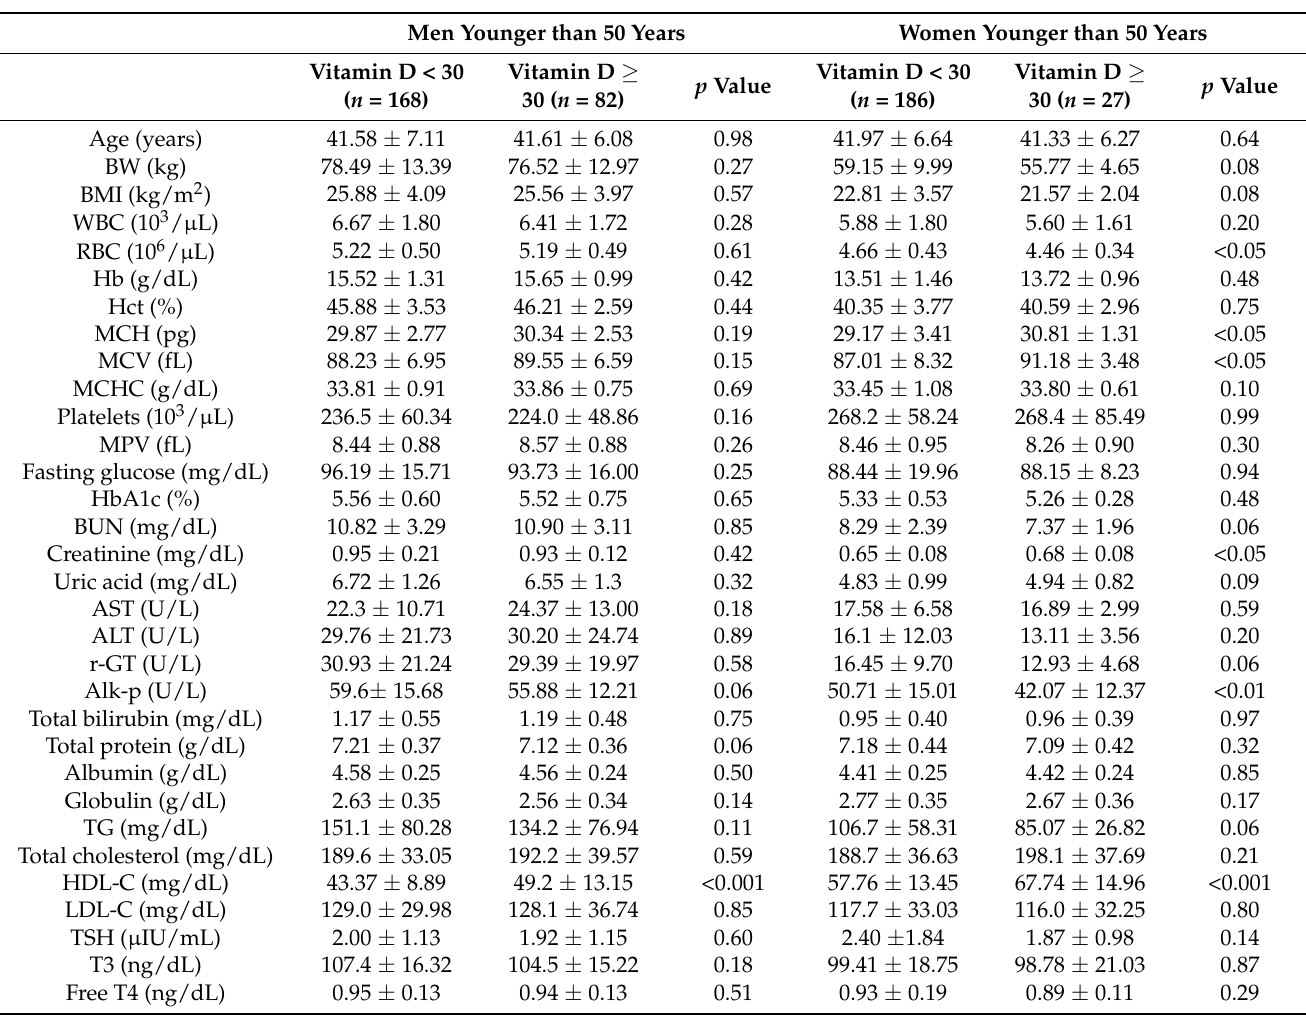
Table 4. Associations between vitamin D status and biomarkers in men and women younger than 50